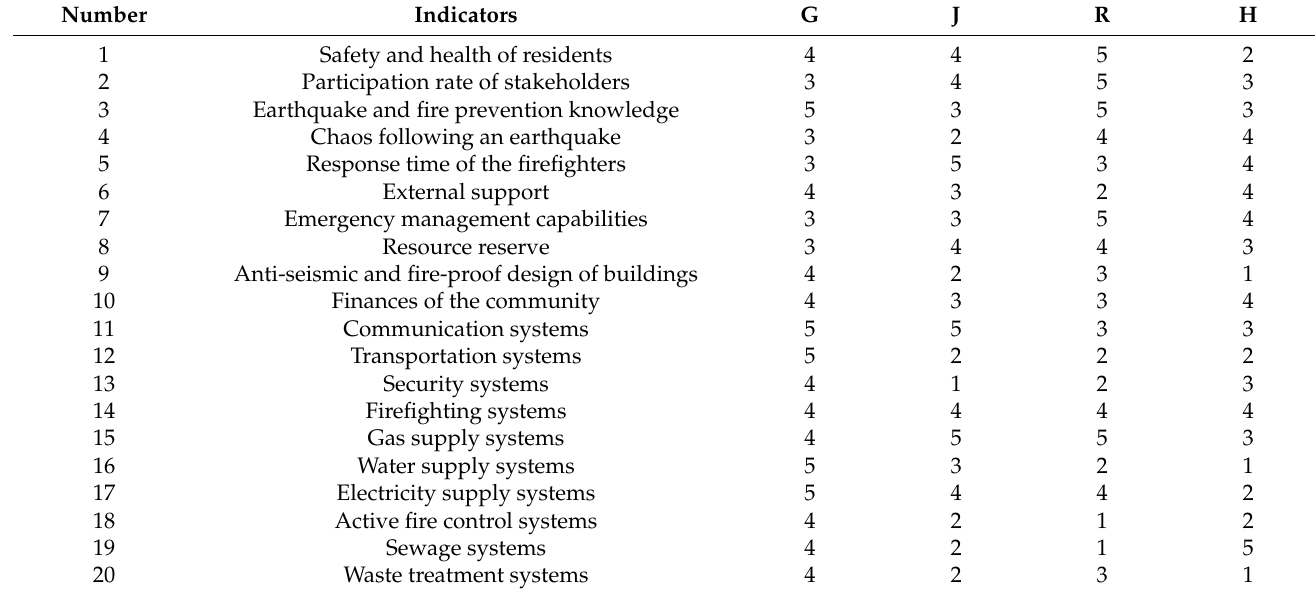
Table 6. The resilience of G, J, R, H communities adapting Liszt’s five-level